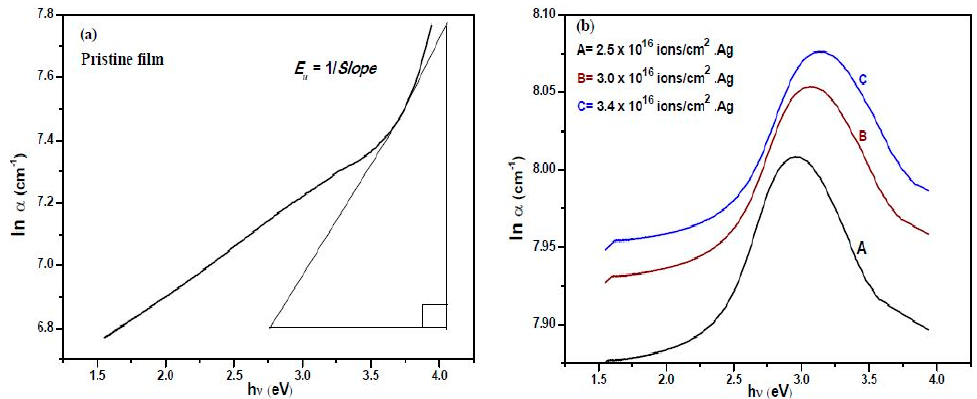
Figure 7. Urbach plots for ( a ) pristine a-C and ( b ) Ag:a-C nanocomposites showing respective Urbach parameters.